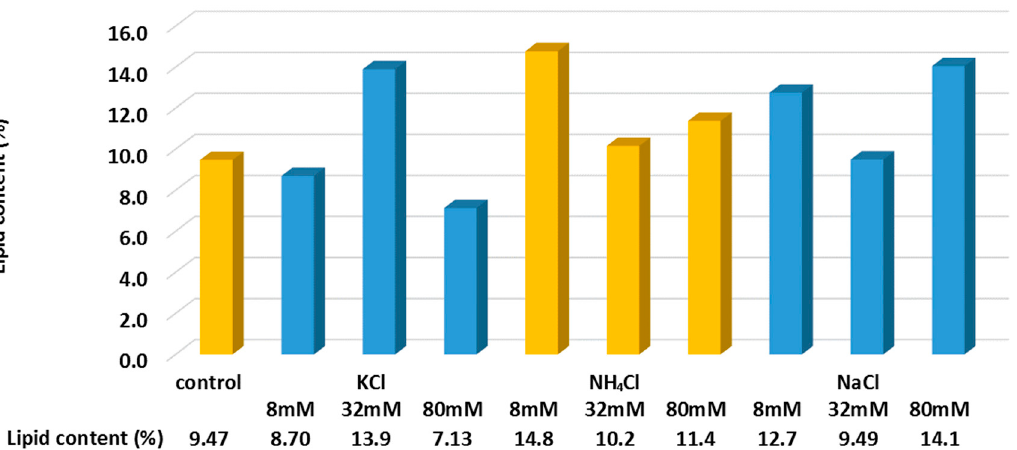
Figure 5. Lipid content (%) change in algal biomass in FS after 2 days of the addition of NaCl, KCl, and NH 4 Cl under different salt concentrations.